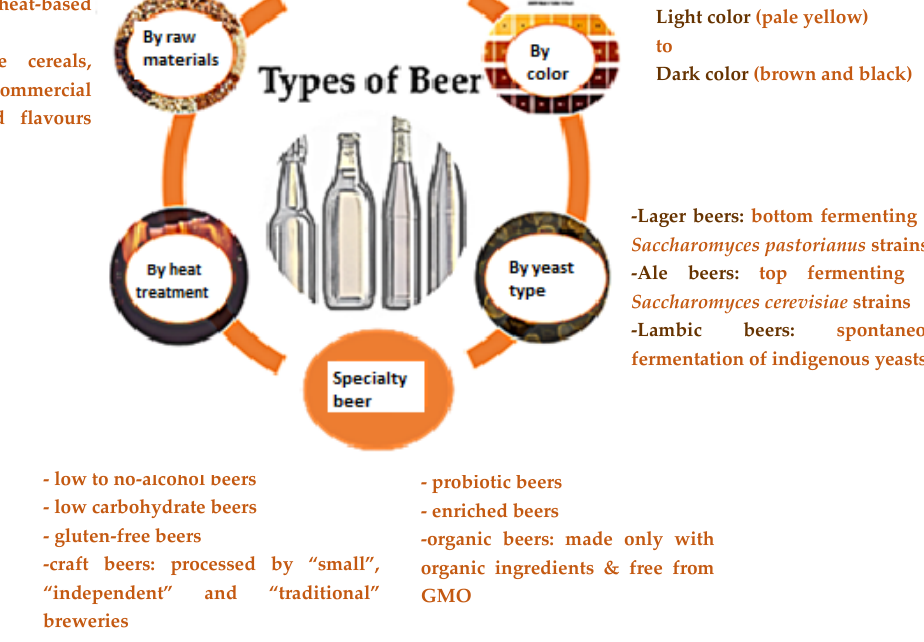
Figure 1. Types of beer according to different classification criteria.